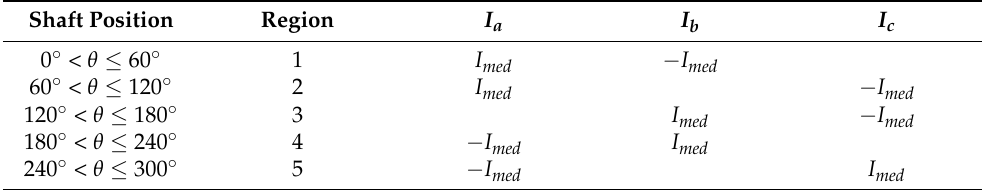
Table 1. Currents in 120° Six-Step Operation.